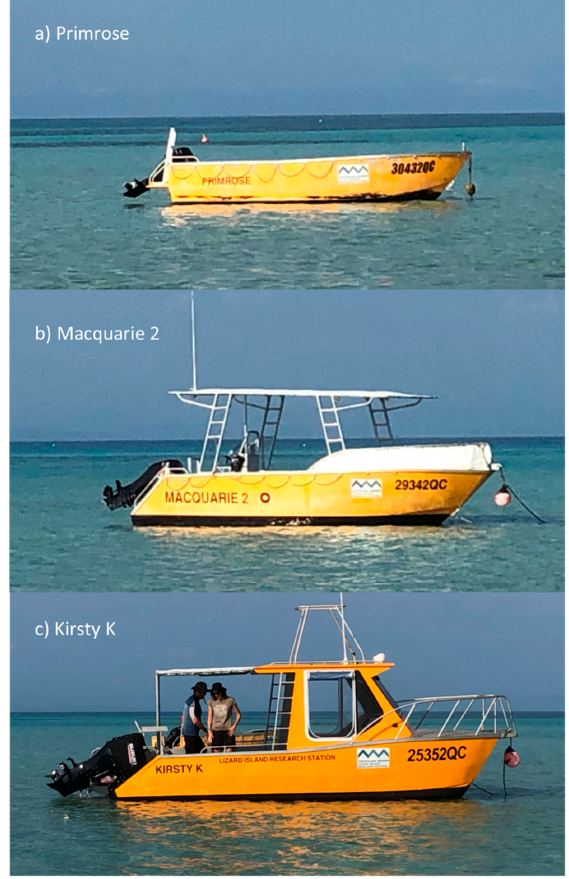
Figure 2. Photos of research vessels ( a ) Primrose , ( b ) Macquarie 2 and ( c ) Kirsty K . Table 1. Specifications of vessels recorded in Lizard Island lagoon.